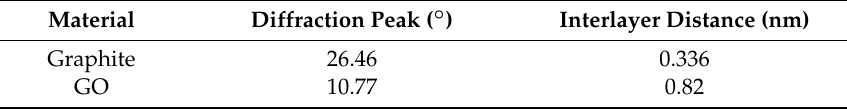
Figure 3. Raman spectrum of graphene oxide.